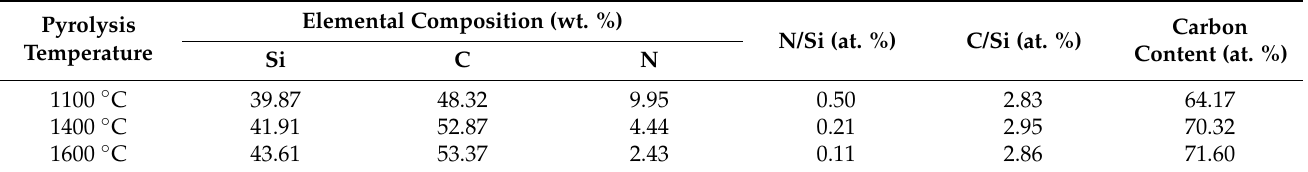
Table 3. Electrical properties of the carbon-rich SiCN materials.